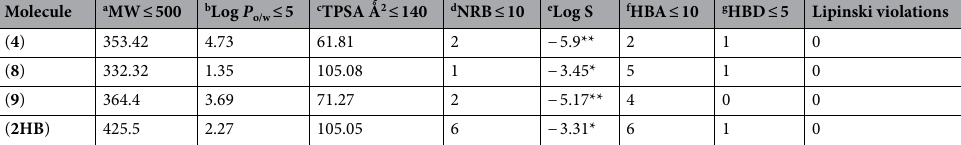
Table 4. In silico physicochemical properties and drug-likeness of compounds 4, 8, and 9, as well as the reference 2HB. a MW, molecular weight. b Log P o/w , partition coefficient octanol/water. c TPSA, topological polar surface area. d NRB, number of rotatable bonds. e Log S, Aqueous solubility (*soluble, **moderately soluble). f HBA, number of H-bond acceptors. g HBD, number of H-bond donors.